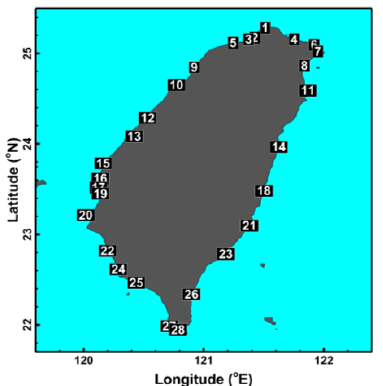
Figure 3. Distribution of the tide-measuring stations along the coastal waters of Taiwan. Table 1. Information for each tide-measuring station along the coastal waters of